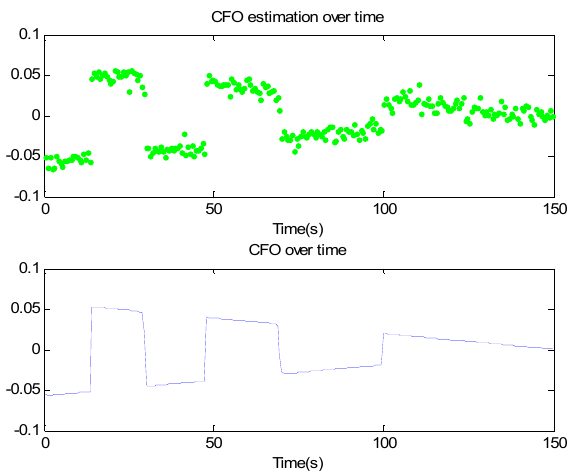
Figure 7. CFO estimation over time with the acceleration of a = − 0.5 m / s 2 .